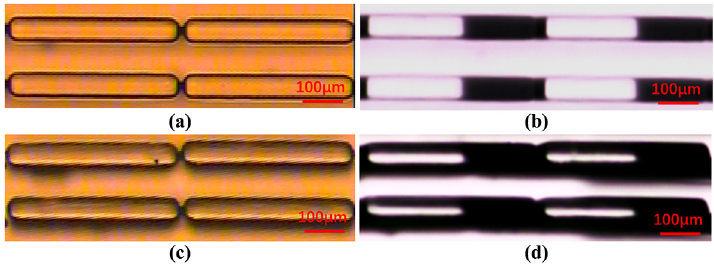
Figure 6. ( a ) Optical microscopic image of the normal structures; ( b ) optical detection image of the normal structures; ( c ) optical microscopic image of the tilted structures; ( d ) optical detection image of the tilted structures.